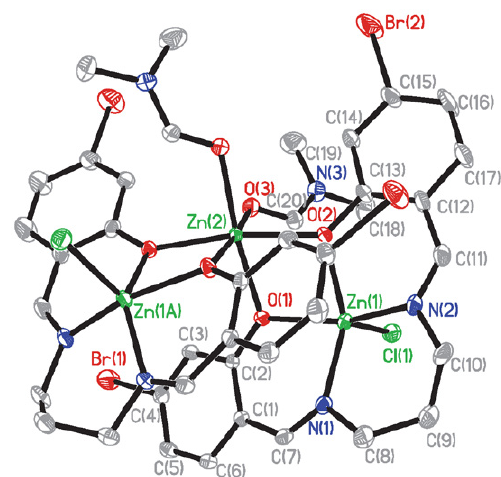
Fig. 3. A perspective view of the molecular structure of complex 2 with the atom labeling scheme. Thermal ellipsoids are drawn at the 30% probability level. The carbon hydrogens are omitted for clarity. Atoms labelled with the suffix A or unlabelled are at the symmetry position 1 – x , y , ½ – z